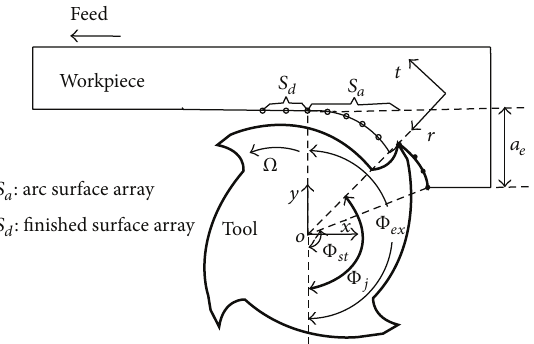
Figure 15: Milling kinematics